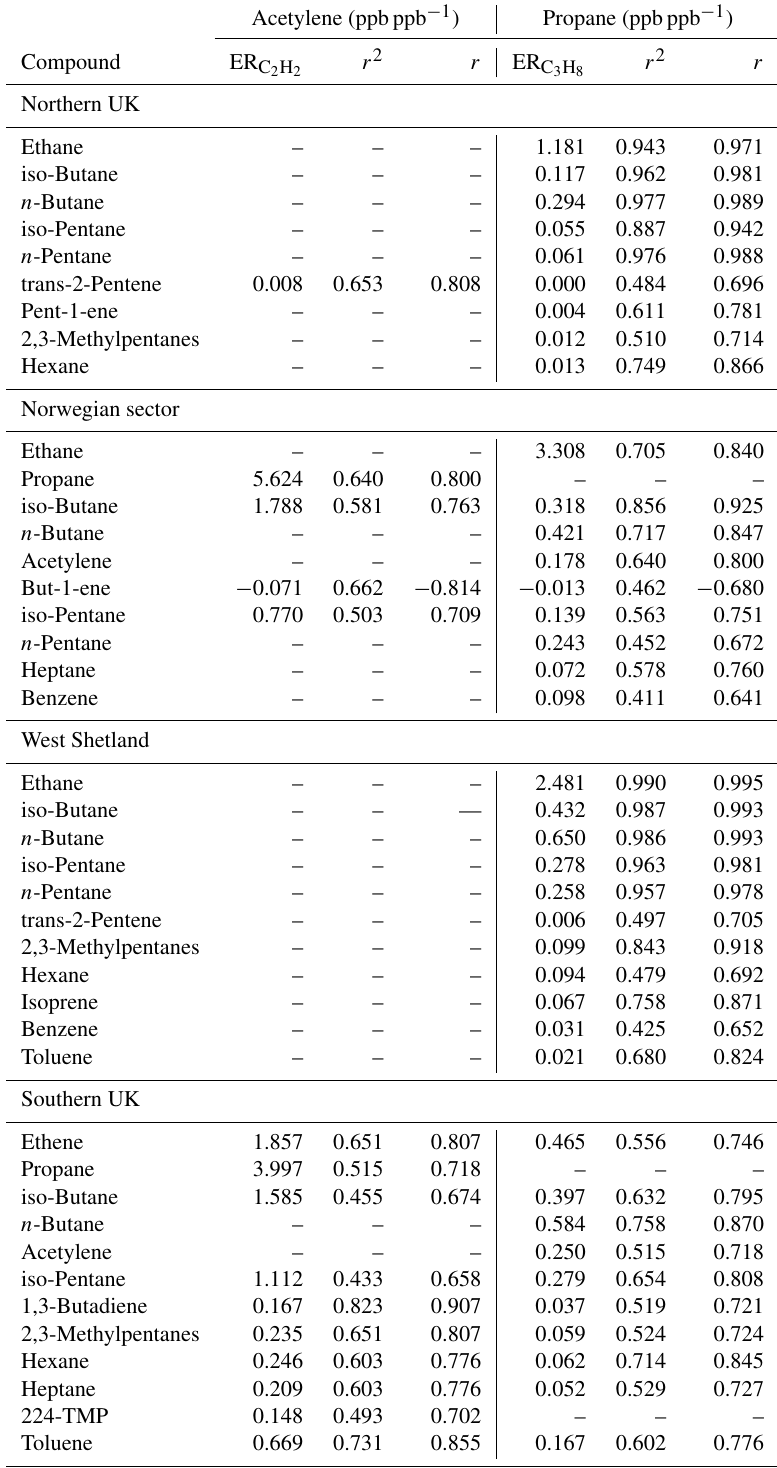
Table 1. Emission ratios (ERs) from the slope of the linear fit using reduced major-axis regression, r 2 values and Pearson correlation coefficients ( r ) for tracer compounds with listed VOCs in each sampling region. Values are only shown for compounds which had correlations with tracer compounds with an r 2 > 0 .